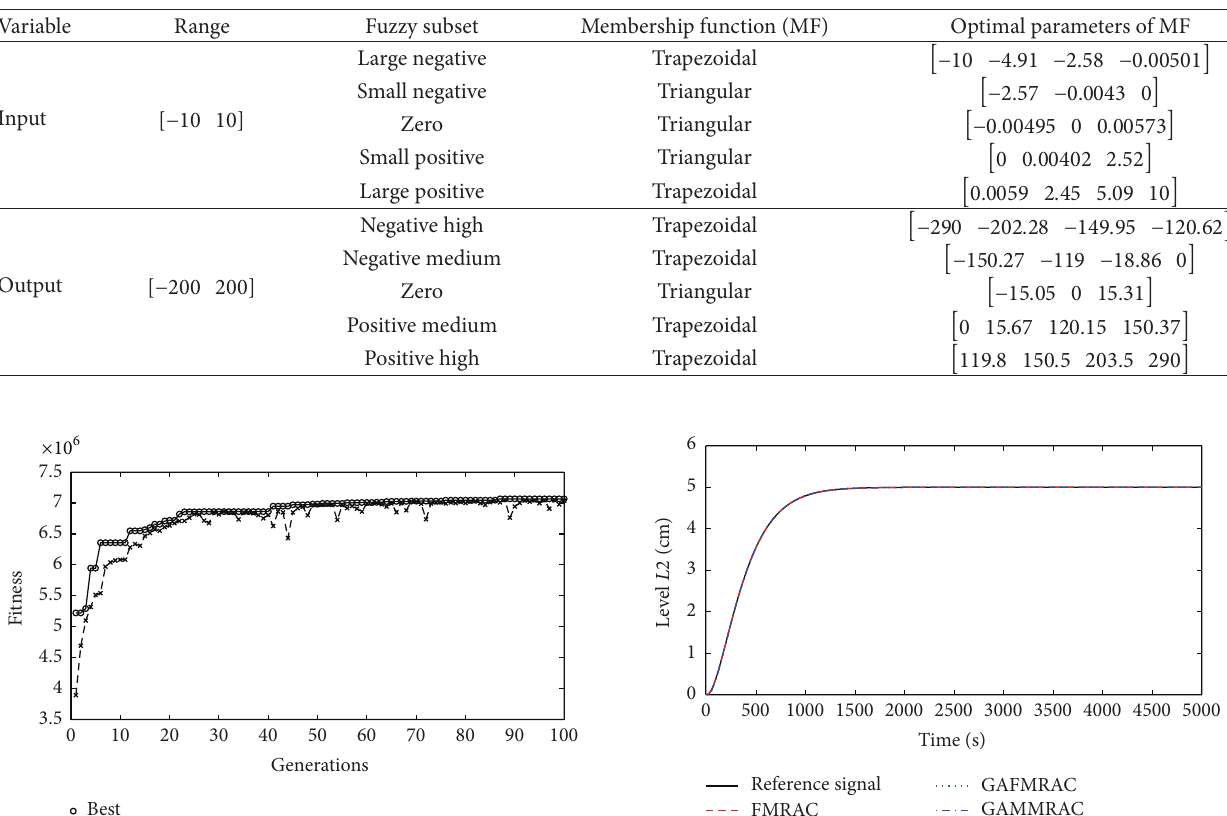
Table 2: Optimal parameters of the MFLC by using RGA.